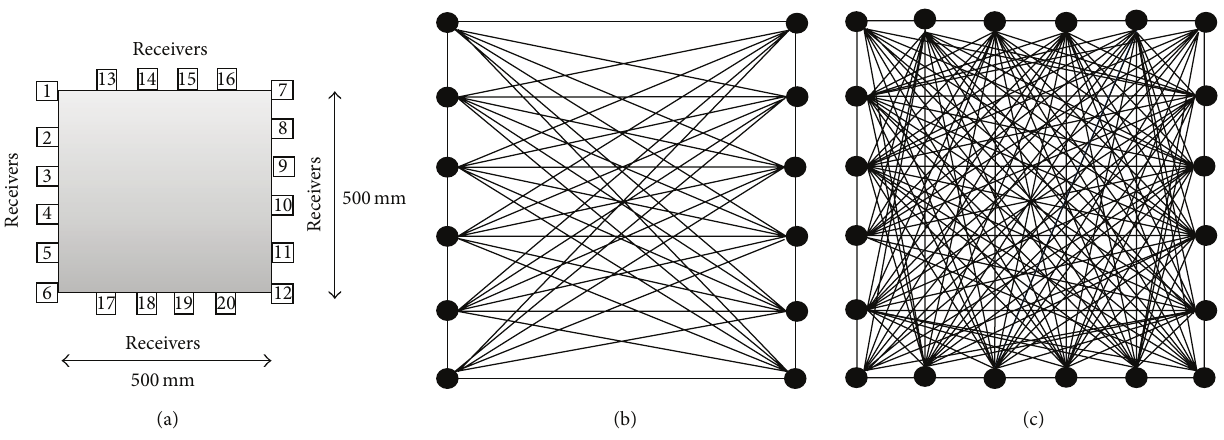
Figure 3: (a) Arrangement of sensors on 500 mm × 500 mm concrete specimen; (b) ray-path coverage with 2-side transducers; (c) ray-path coverage with 4 sides transducers (complete coverage).